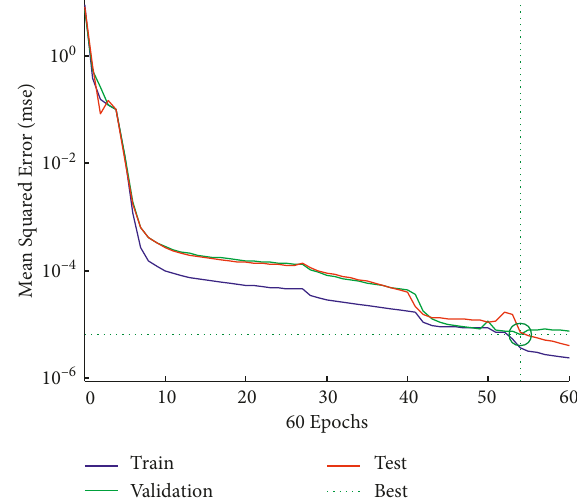
Figure 10: Training curve of the BP neural network.